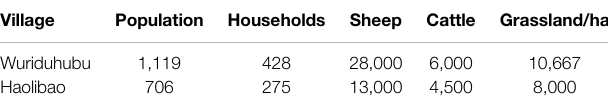
TABLE 2 | The socioeconomic status of herder villages in